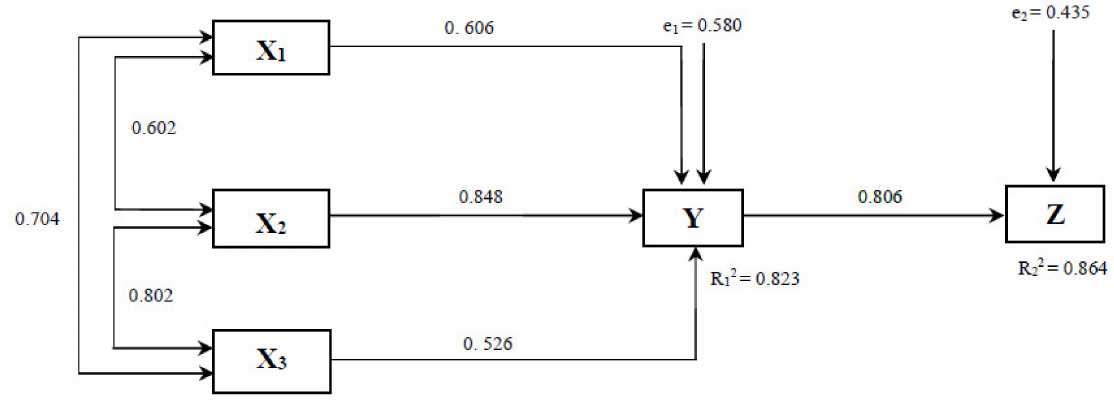
Figure 10. Relationship control of spatial use, land reclamation handling, and infrastructure improvement toward improvement of environmental quality and sustainability of slum settlement